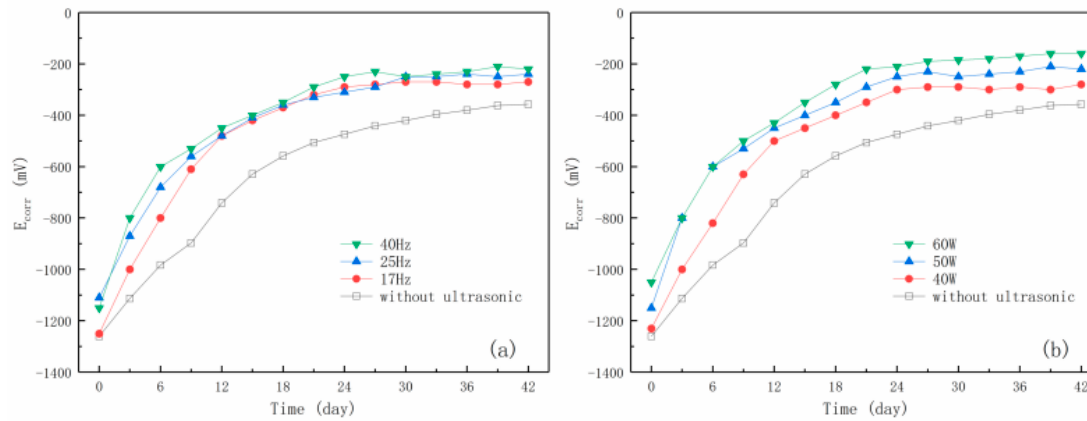
Figure 6. The curves of corrosion potential of steel bar in desalting specimens with time. ( a ) Different ultrasound frequencies; ( b ) different ultrasound powers.